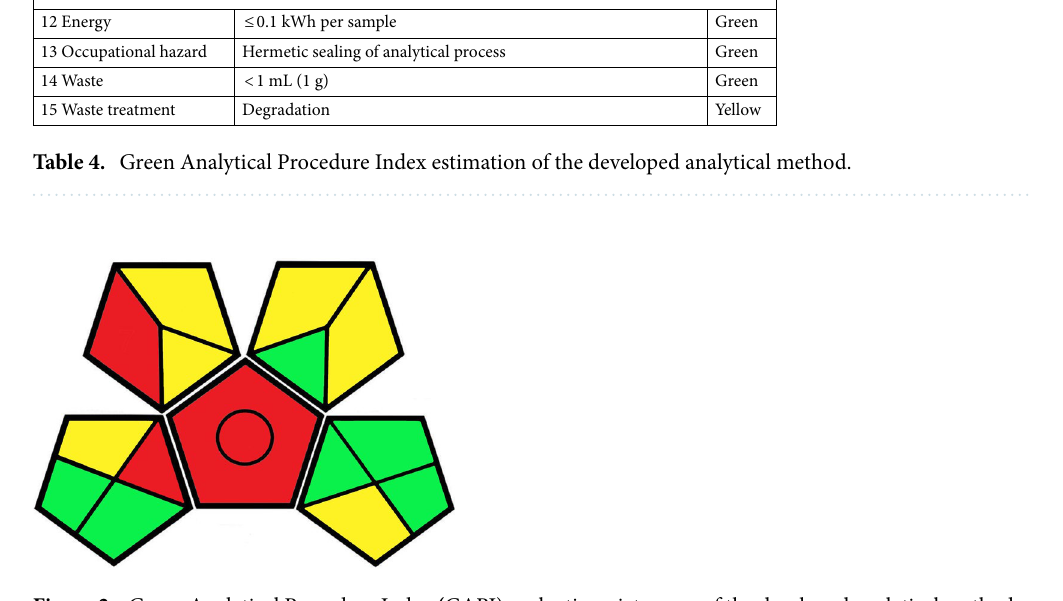
Figure 2. Green Analytical Procedure Index ( GAPI) evaluation pictogram of the developed analytical method.